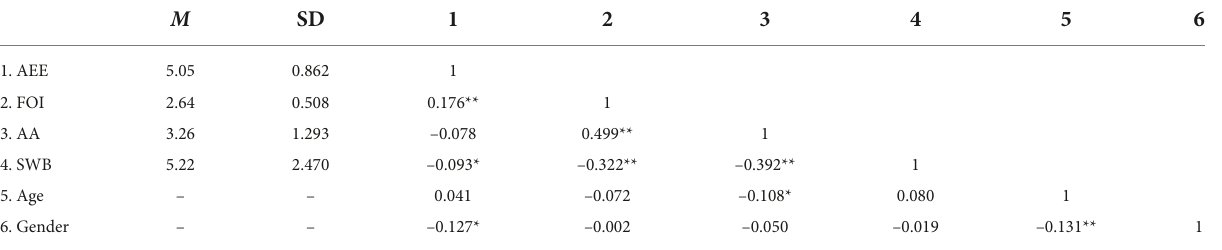
TABLE 2 Mean values, standard deviations (SD), and correlations among study variables ( N =